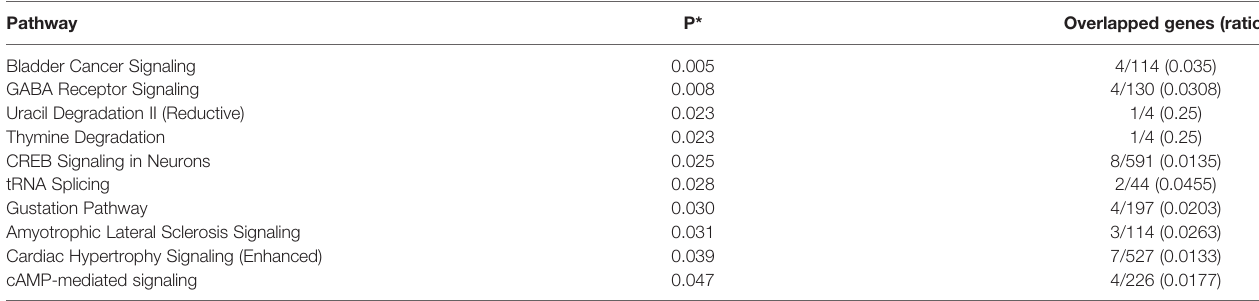
TABLE 3 | Canonical pathways of differentially methylated positions (DMPs) in placental genes in GDM vs. control groups. Pathway P* Bladder Cancer